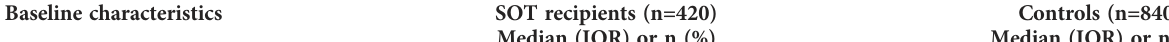
TABLE 1 Baseline characteristics of solid organ transplant recipients and matched controls after third dose of a SARS-CoV-2 mRNA vaccine. Baseline